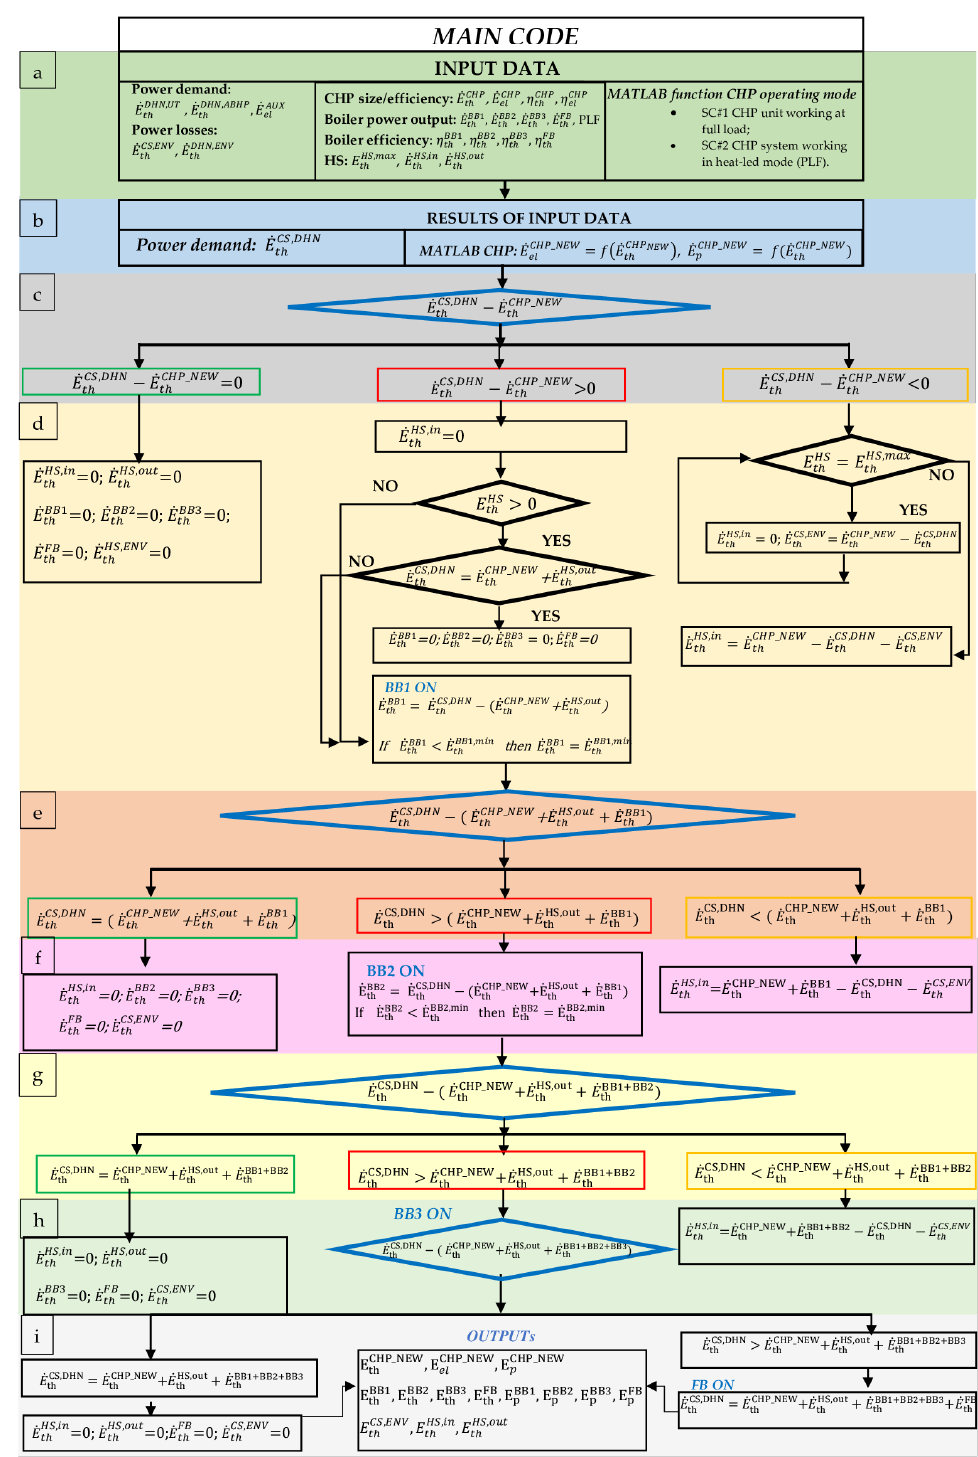
Figure 5. Biomass-based model flow chart: ( a ) input data; ( b ) results of the input elaboration; ( c ) first control CHP; ( d ) development of the first control; ( e ) second control BB1; ( f ) development of the second control; ( g ) third control BB2; ( h ) development of the third control and fourth control-BB3; ( i )